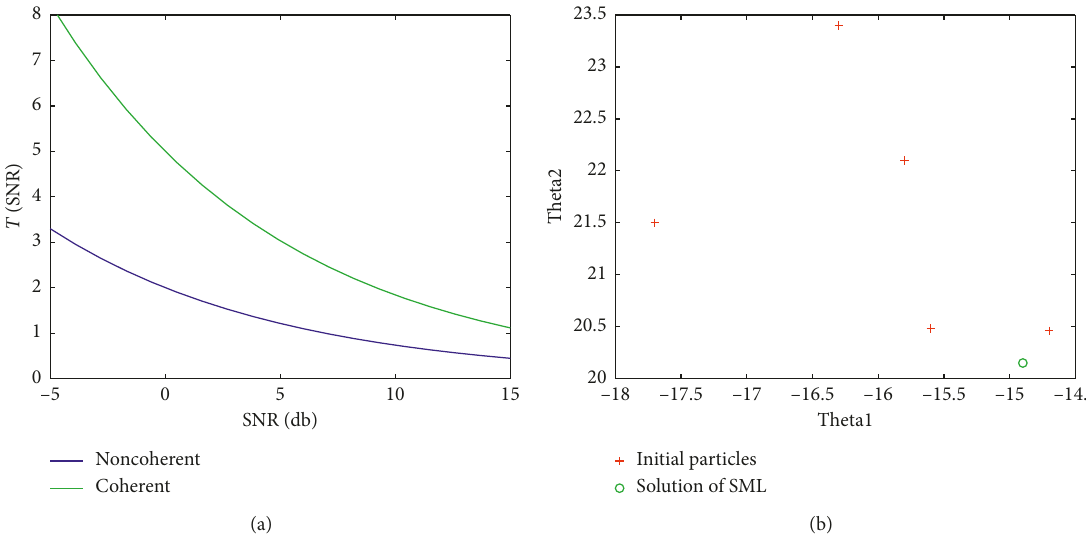
Figure 3: Improvement of the initialization space. (a) The “scale” function. (b) Positions of initial particles and the solution of SML (the scenario is the same as Figure 2(a)).